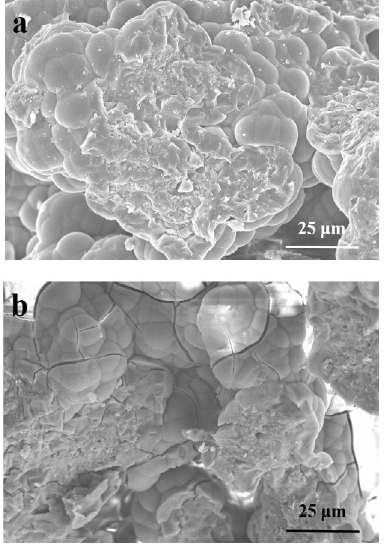
Fig. 11 Fracture morphologies of porous Si 3 N 4 –Si 3 N 4 composite ceramics (S4): (a) before heat treatment and (b) after heat